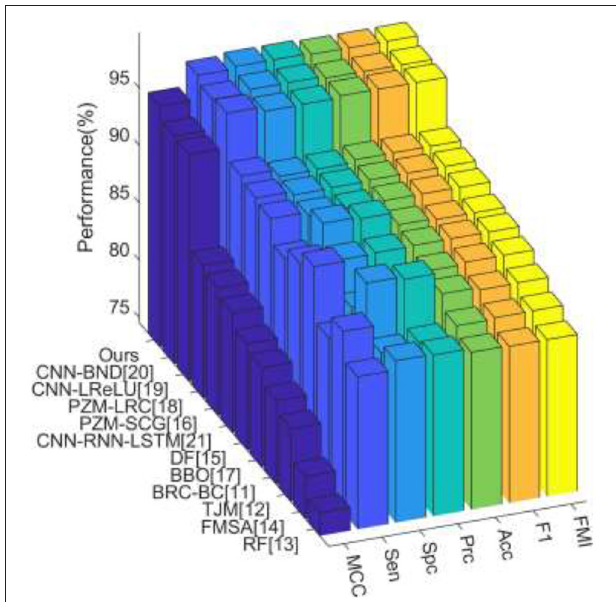
FIGURE 15 | Bar plot of all